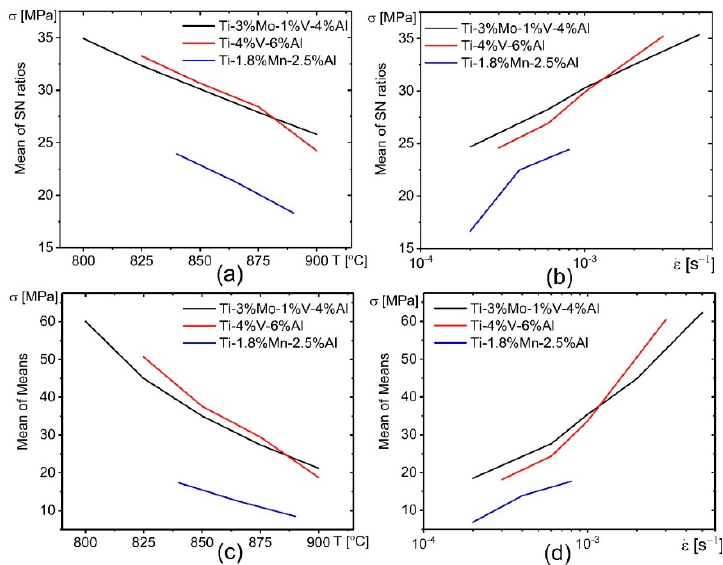
Figure 7. Dependence of the σ s on the temperature and strain rate for the investigated alloys: ( a , b ) Means of S/N ratios; and ( c , d ) mean of means. Table 4. Analysis of variance for the S/N ratios of the σ s .